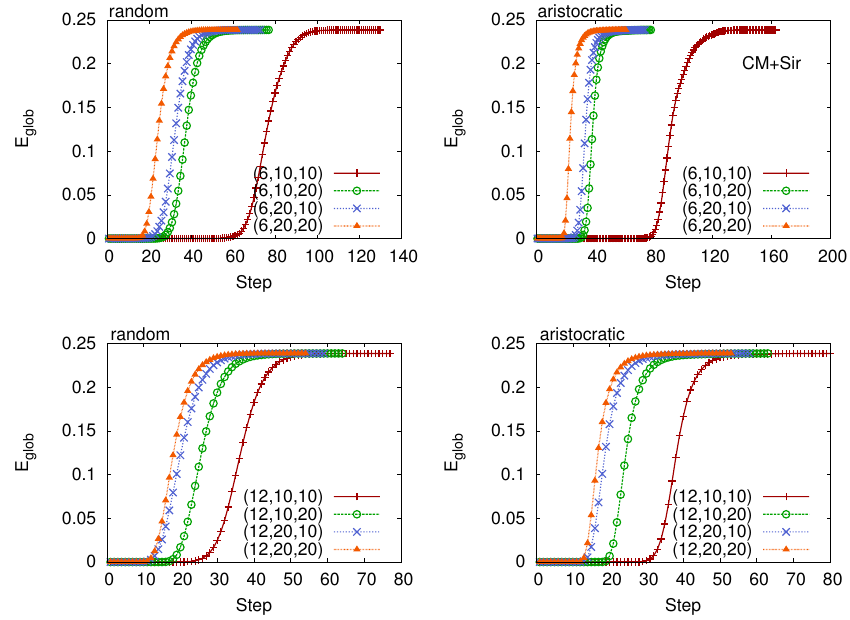
Figure 17. Accelerated analysis with mermaids, broadcast model (for mermaids’ dynamics), Communities online social network, fixing m = 6 ( top panels ), and m = 12 ( bottom panels ). Three cost levels are then considered for each